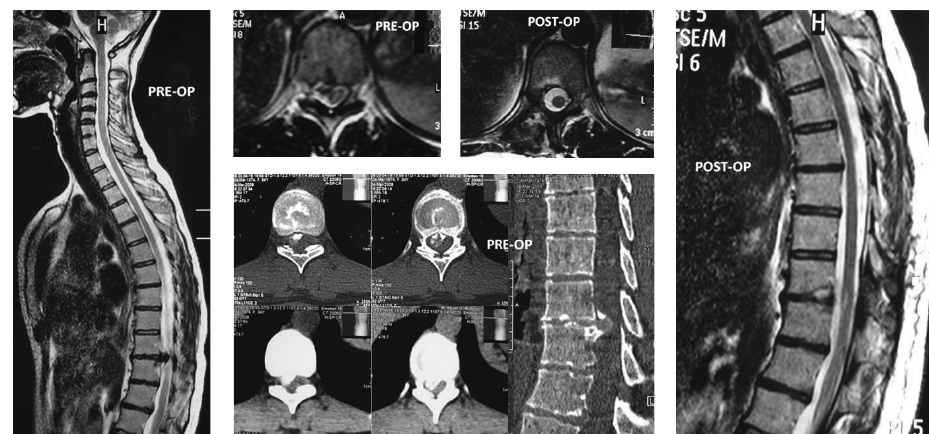
Figure 5: 34-year-old female. In the neurological examination there was paraparesis in lower extremities (ASIA C). Cord compression of a thoracic 9-10 disc herniation (Case 10). Preoperative CT and MR images at the left side and postoperative images at the right